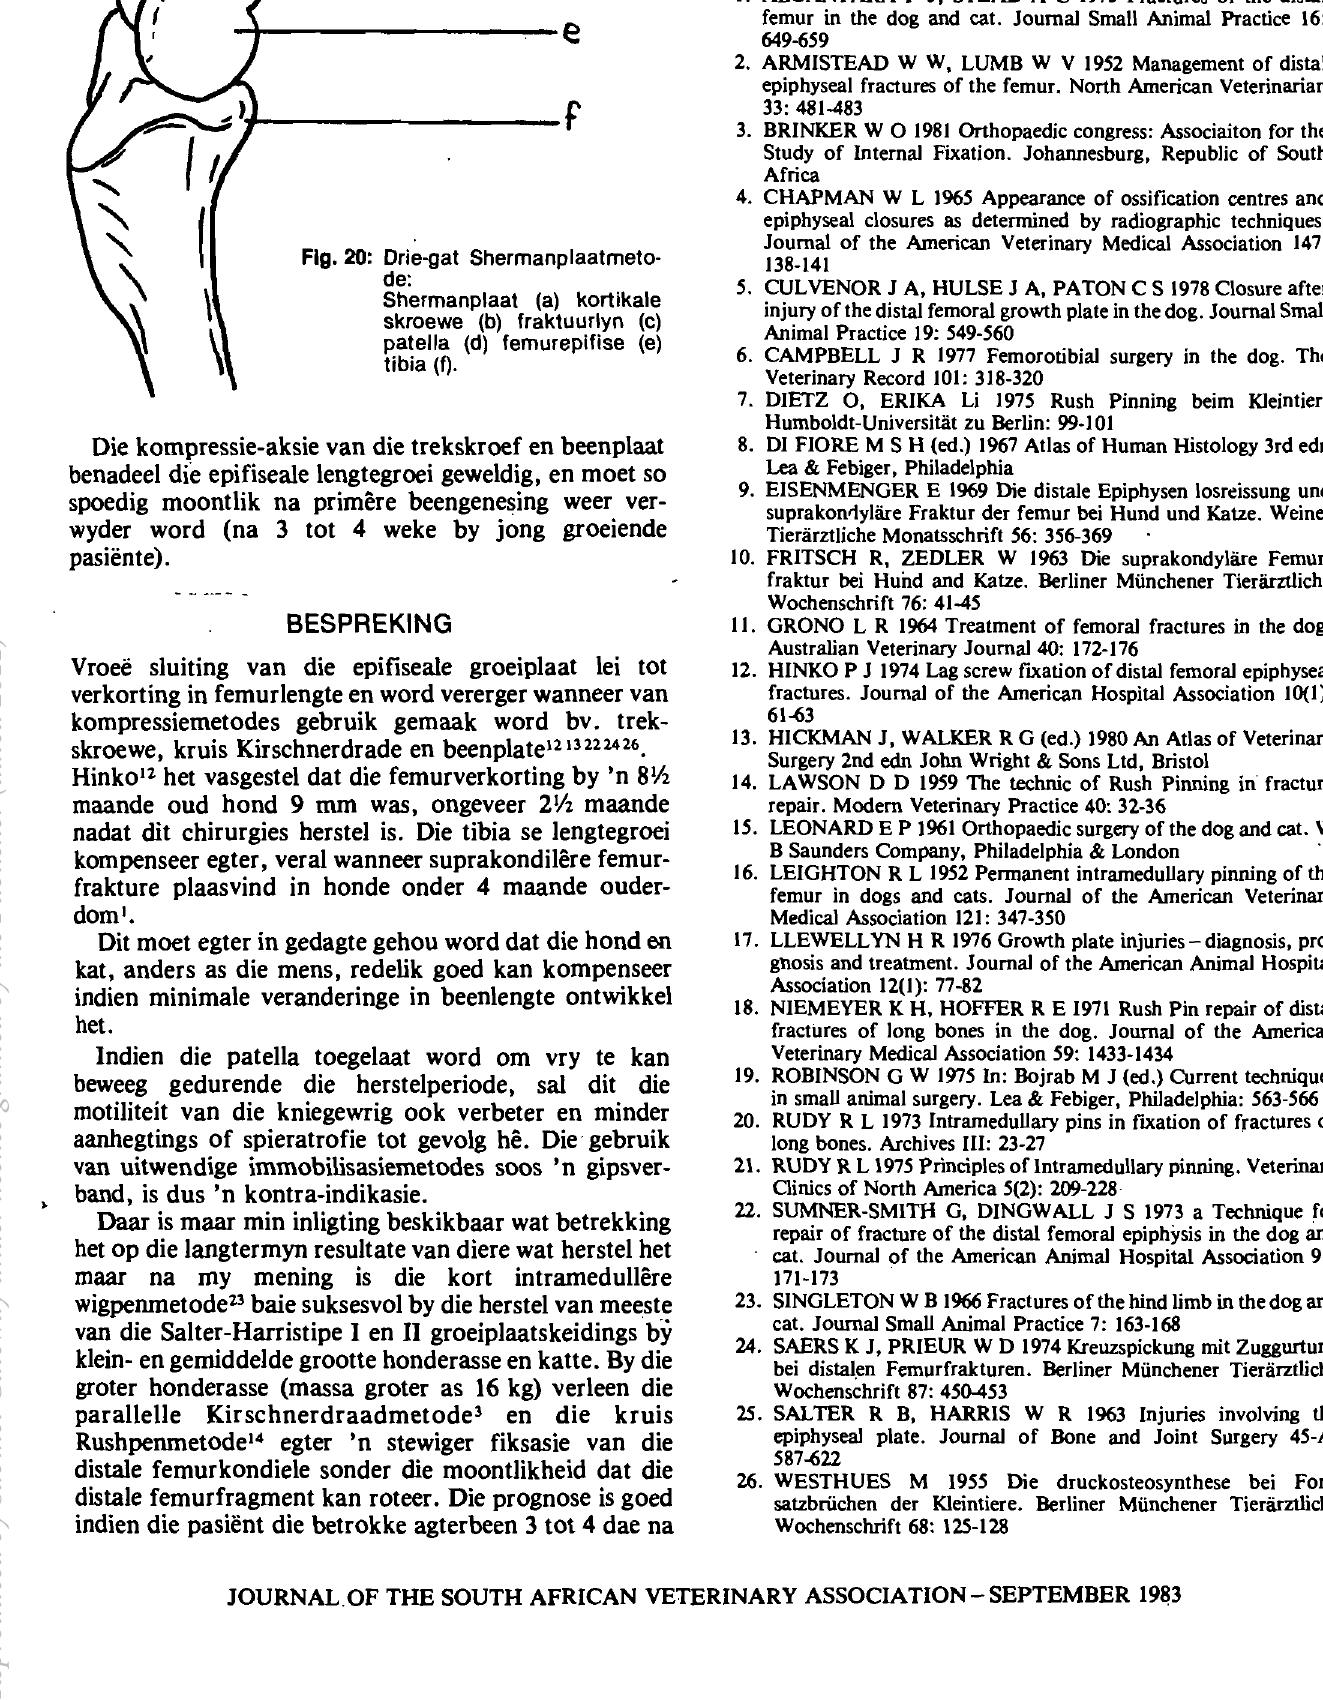
Fig. 20: Drie-gat Shermanplaatmeto de: Shermanplaat (a) kortikale skroewe (b) fraktuurlyn (e) patella (d) femurepifise (e) tibia